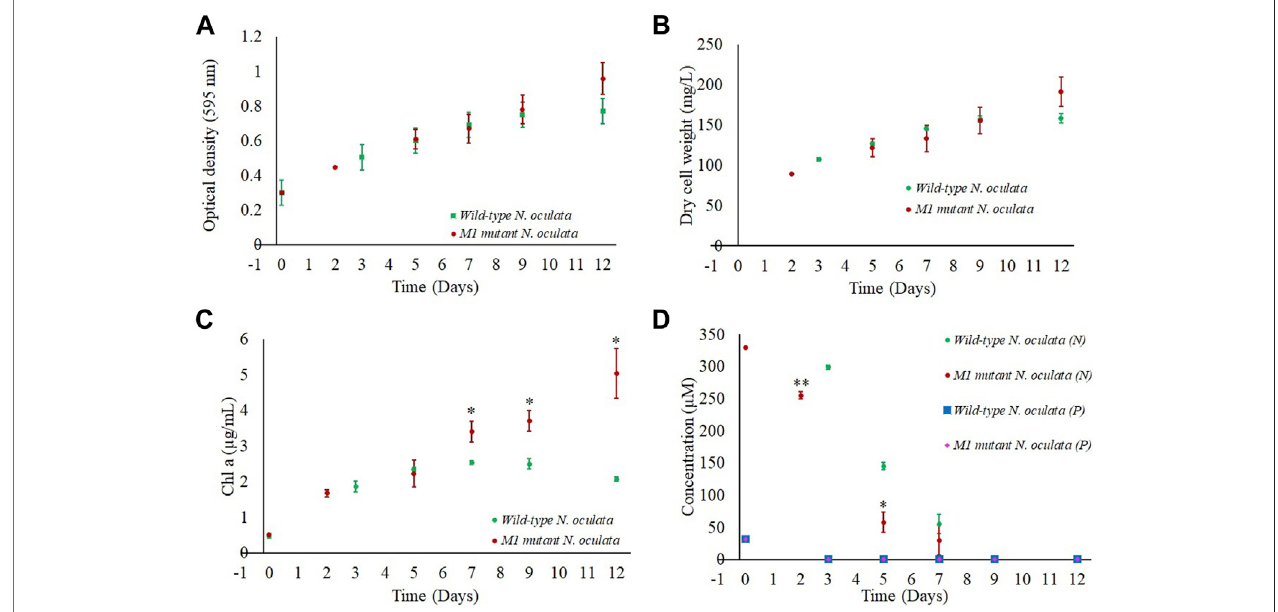
FIGURE 4 | Growth pro fi les for wild-type and M1 mutant N. oculata cultivated in 1-L fl asks under 150 μ mol m − 2 s − 1 , 20 ° C, and aerated bubbling for mixing and carbon source for12 days. (A) Growthcurvesillustrated byoptical densityat 595 nmand (B) DCW.Comparison ofwild-type andM1mutant N.oculata over 12 daysof culturing for (C) chlorophyll concentration and (D) phosphate (P) and nitrate (N) uptake pro fi les. Mean ± standard deviation is shown ( n = 3) and t -tests determine the statistical signi fi cance ( p < 0.05 [*]; p < 0.01 [**]; and p < 0.001 [***]) of the M1 mutant strain compared to the wild-type strain.